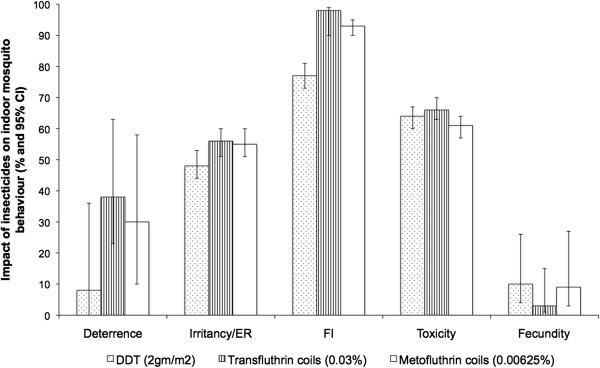
Overall impact of insecticides on mosquito behaviour insides houses. The graph illustrates the mode of action of DDT, Transfluthrin and Metofluthrin coils on mosquito behaviour. The outcomes measured included deterrence, irritancy, feeding inhibition and toxicity. The value of deterrence was derived from the effect of insecticides on An. arabiensis mosquitoes from field experiments and irritancy, feeding inhibition, mortality and fecundity of An. gambiae s.s. mosquitoes from the semi field system experiment.